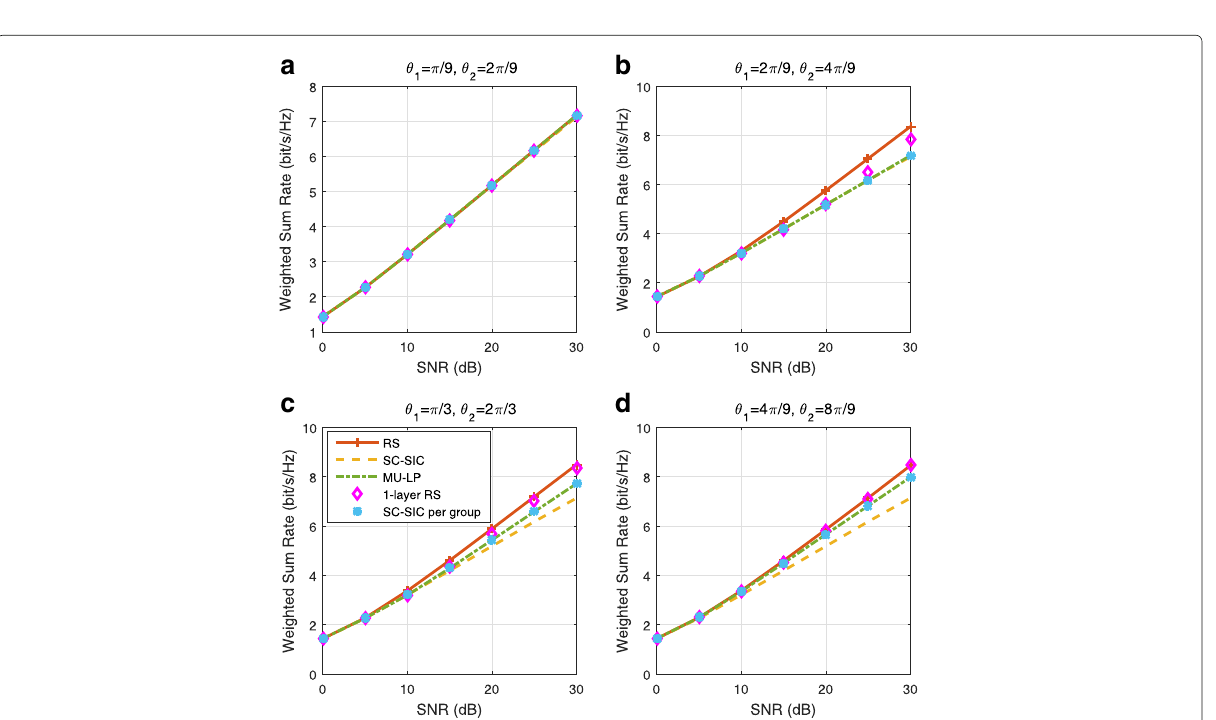
Fig. 51 WeightedsumrateversusSNRcomparison of different strategies for underloaded three-user deployment with imperfect CSIT, γ 1 = 1, γ 2 = 0.3, u 1 = 0.6, u 2 = 0.3, u 3 = 0.1, N t = 4, R th